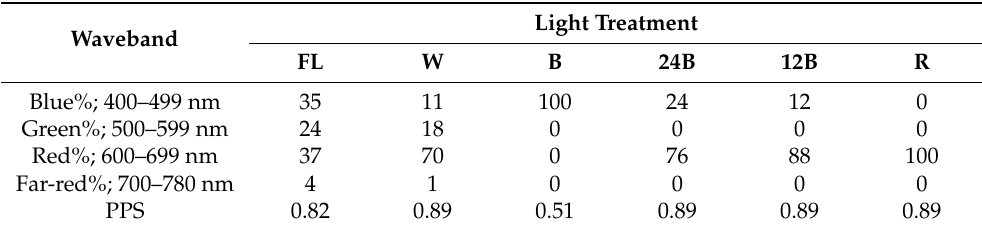
Table 1. Spectral distribution expressed as percentages of total photons reaching the seedling